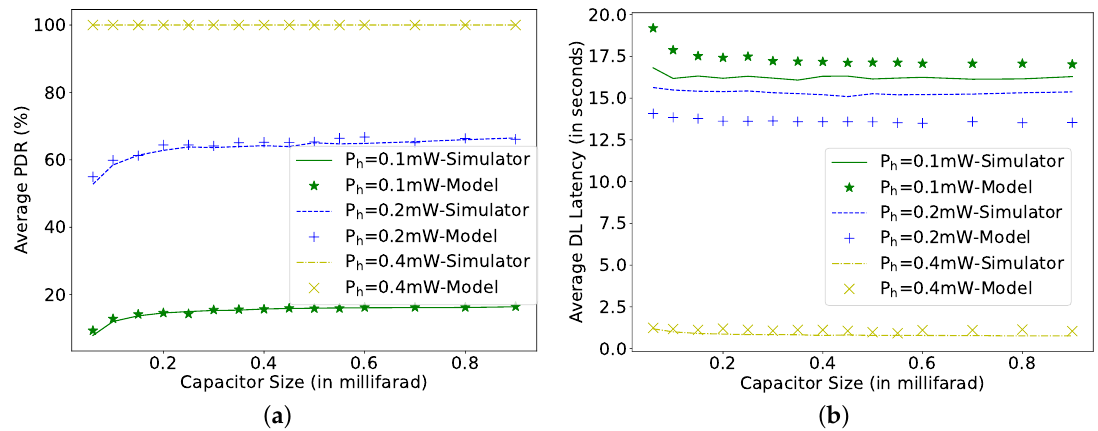
Figure 10. Comparing simulator and model for different capacitor sizes and harvesting power at µ p = 1 s, T PI = 1 s, N = 16, T AT = 0 ms. ( a ) Average packet delivery ratio; ( b ) DL latency.